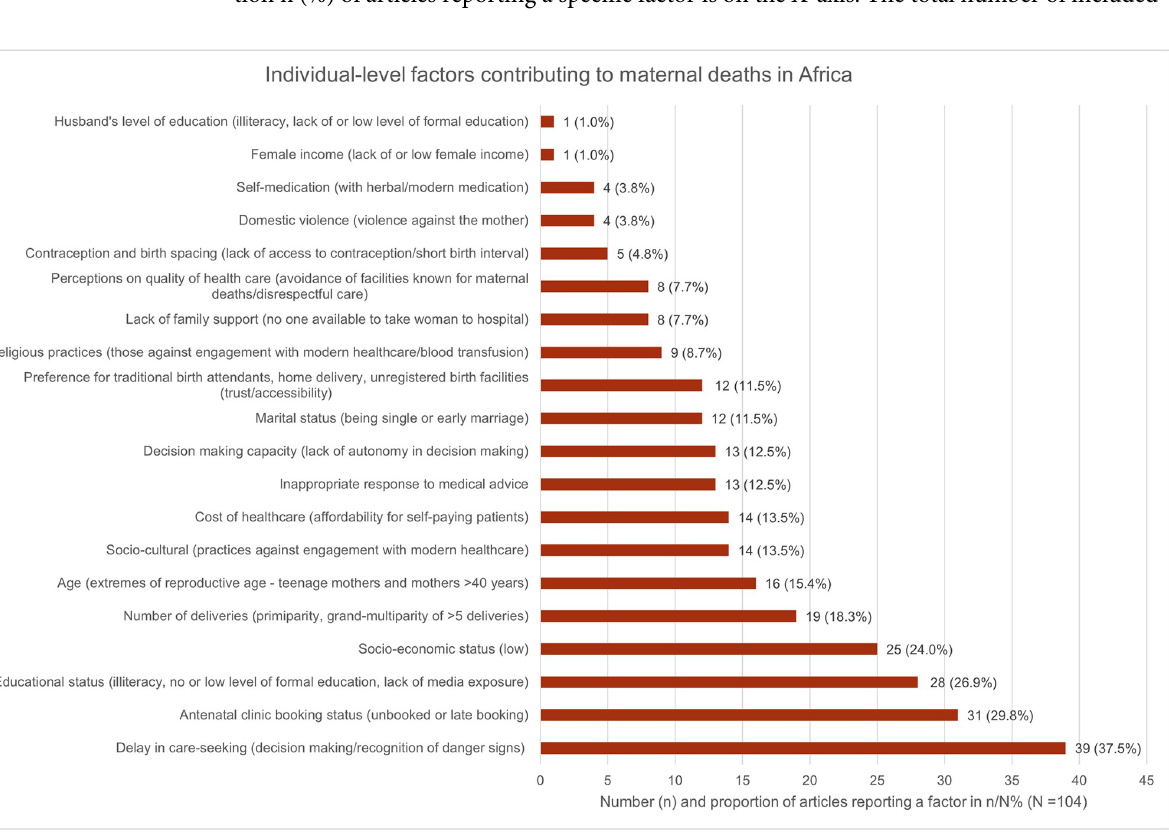
Fig 3. Individual-level factors contributing to maternal deaths in Africa. They are ranked from the most frequently reported (delay in care-seeking) to the least frequently reported (husband’s level of education). The number and proportion n (%) of articles reporting a specific factor is on the X-axis. The total number of included articles (N = 104) is the denominator. The factors and their explanatory descriptions are on the Y-axis.